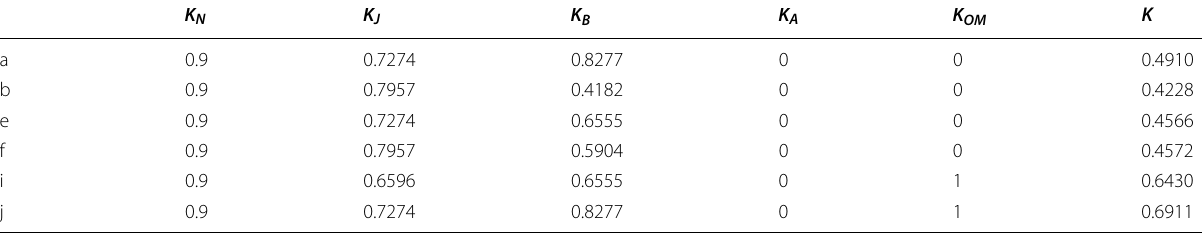
Table 5 Complexity indices of the